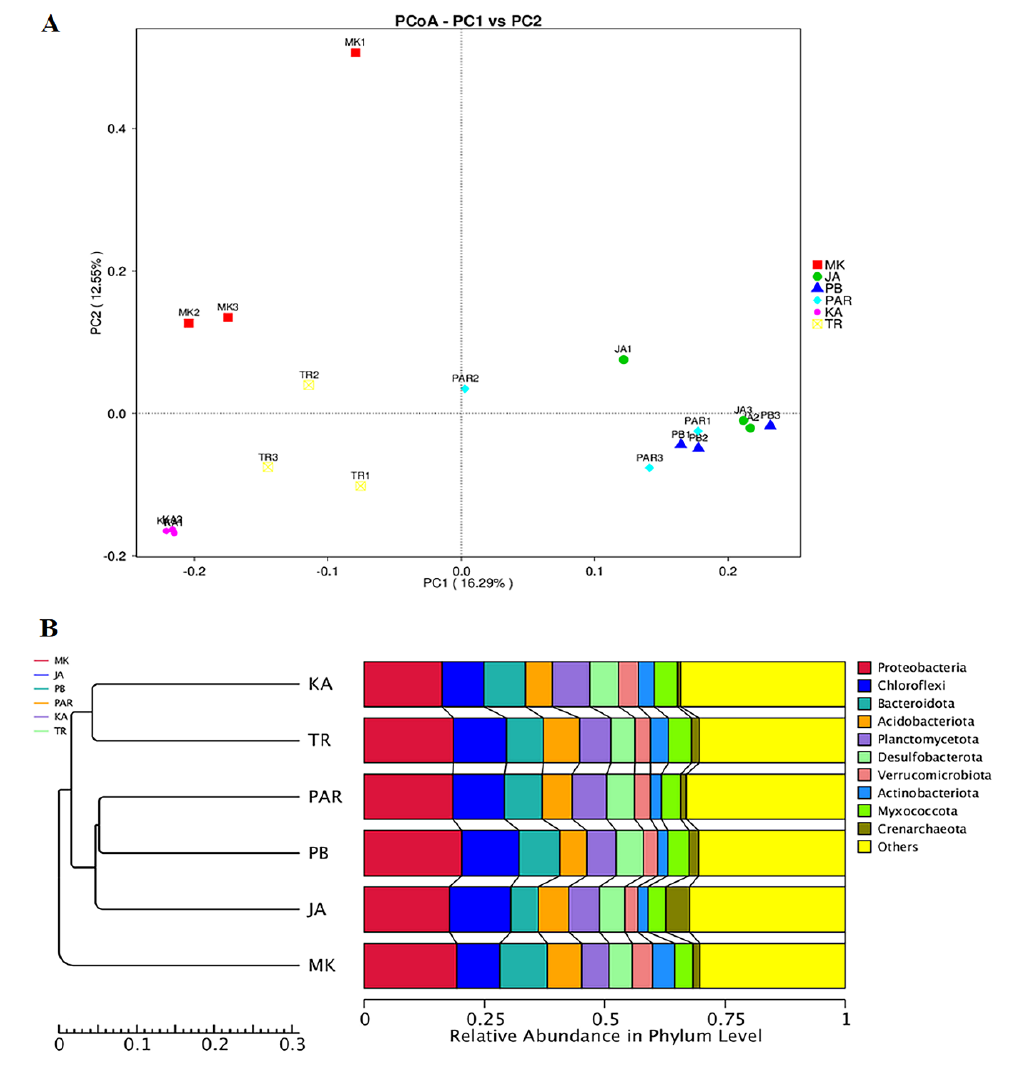
Figure 5 . Clustering of bacterial communities . Principal coordinate analysis ( PCoA ) of bacterial composition similarity according to sampling site ( A ) ; UPGMA dendrogram of relative abundance at phylum level form each sampling site ( B ). The site codes are in accordance with those listed in Table 1 .